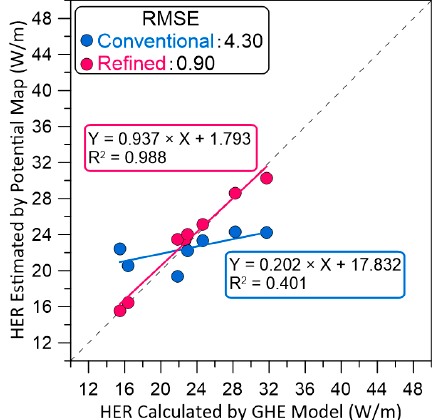
Figure 14. Comparison of the heat exchange rate calculated by GHE models with that estimated by the RSM in the Sendai Plain. RSM in the Sendai